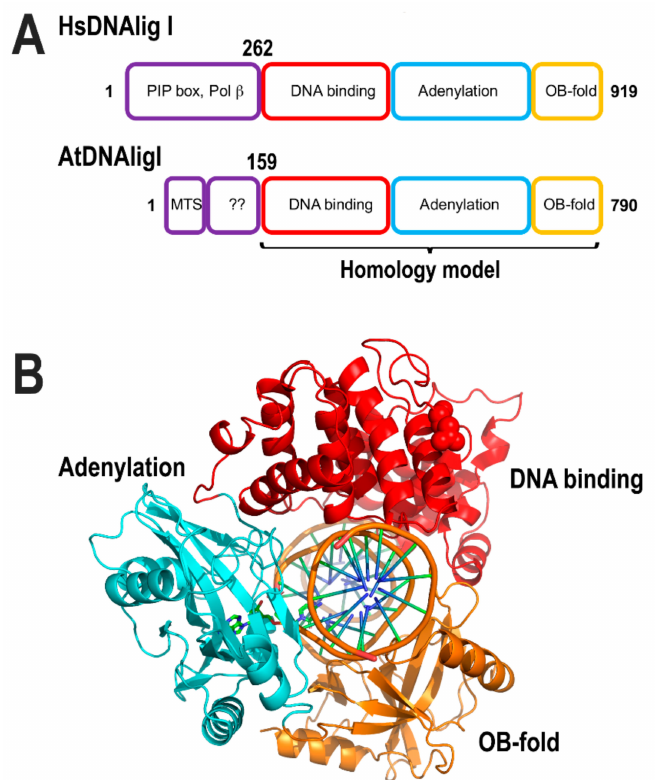
Figure 12. Structural comparison between HsDNAligI and AtDNligI. ( A ) AtDNAligI has a shorter N-terminal region. However, the core structure that harbors the DNA binding domain (red) the adenylation domain (cyan) and the OB-fold domain (orange) are conserved between both ligases. ( B ) Homology modeling of AtDNAlig I with basis on the crystal structure of human DNA ligase I (PDB ID: